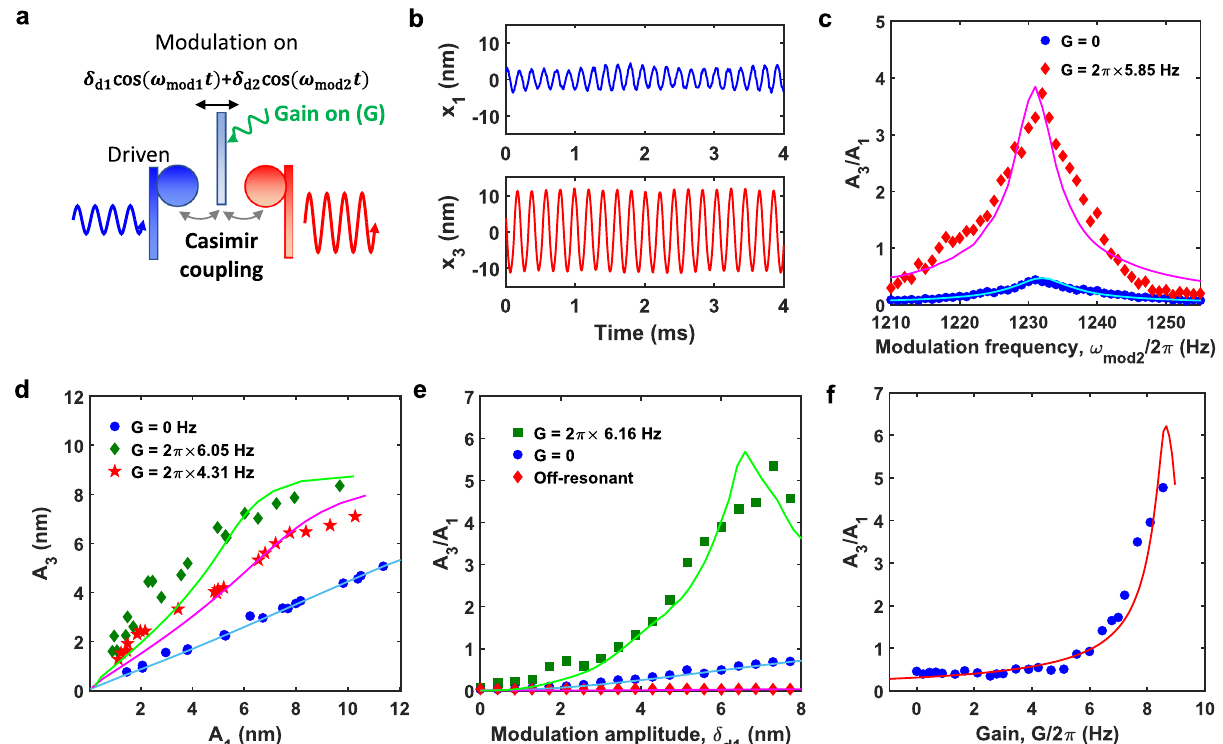
Fig. 4 | Amplifying quantum- fl uctuation-mediated energy transfer. a An extra gain G is applied on cantilever 2 by feedback control together with parametric modulation. b The signal on cantilever 1 ( x 1 ) is transmitted to cantilever 3 ( x 3 ) with ampli fi cation. c The transduction ratio A 3 / A 1 is shown as a function of modulation frequency ω mod2 when the gain ison (red diamonds)and off(blue circles). ω mod1 is onresonantforbothcases. G isthegaincoef fi cientoncantilever2.Undertheextra gain,the dampingrateofcantilever2becomes γ 2 = γ 20 − G , where γ 20 isthe natural damping rate. The cyan and magenta solid curve are the simulations. d The